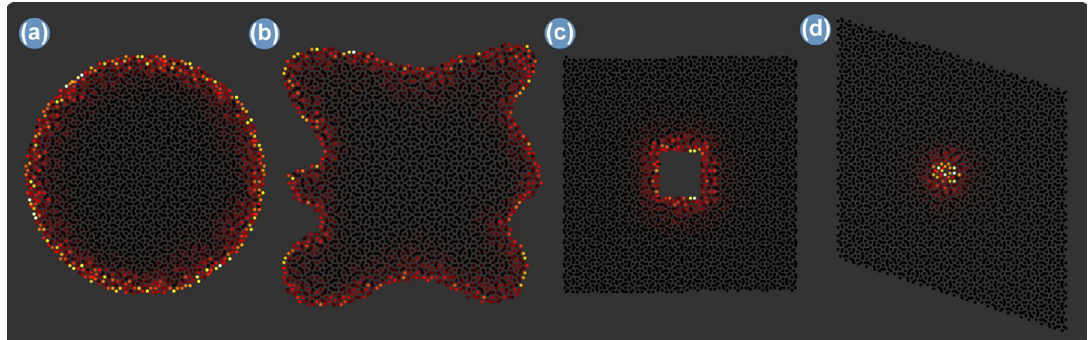
FIG. 6. Topological edge states associated with the topological gap shown in Fig. 4(d), for different shapes of the finite quasicrystal (a) circle, (b) arbitrary shape, (c) hole, and (d) a bulk defect (a missing waveguide in the bulk of the